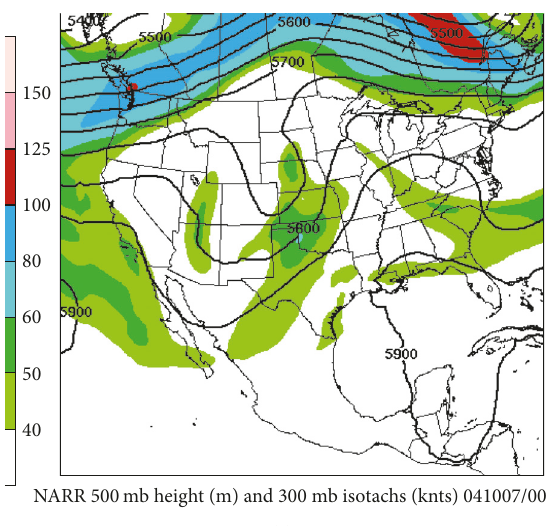
Figure 7: 500 mb geopotential heights for Case Study 1 (a); 500-hPa geopotential height (m) from the NARR dataset for Case Study 2 (b); 500-hPa geopotential height (m) from the NARR dataset for Case Study 3 (c). (Image provided by the NOAA/ESRL Physical Science Division, Boulder Colorado from their Web site at https://www.esrl.noaa.gov/psd/.) In these plots, the 𝑥 axis is the longitude and 𝑦 axis is the latitude. The black contour lines are geopotential height contours (m) and the shaded color bars are the isotachs (knots).